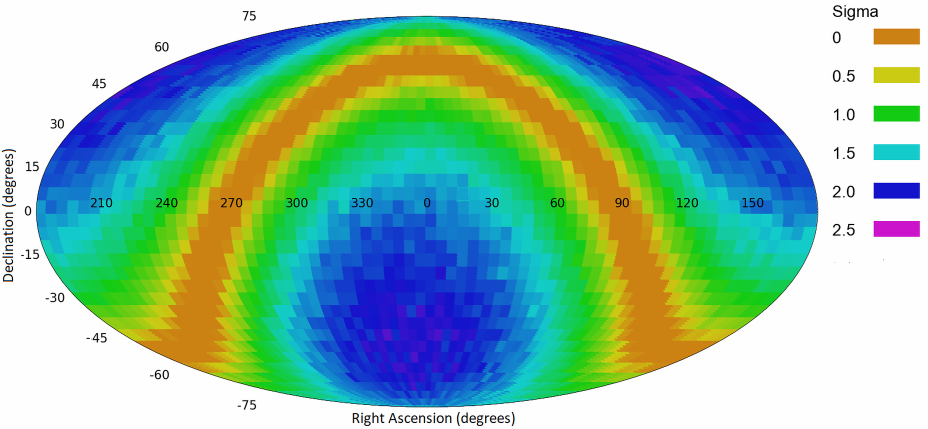
Figure 11. The χ 2 statistical significance of a dipole axis in the spin directions of the galaxies from different ( α , δ ) combinations in the exact same dataset used by [210]. Code and data to repro- duce the analysis are available at https://people.cs.ksu.edu/~lshamir/data/iye_et_al (accessed on 2 June